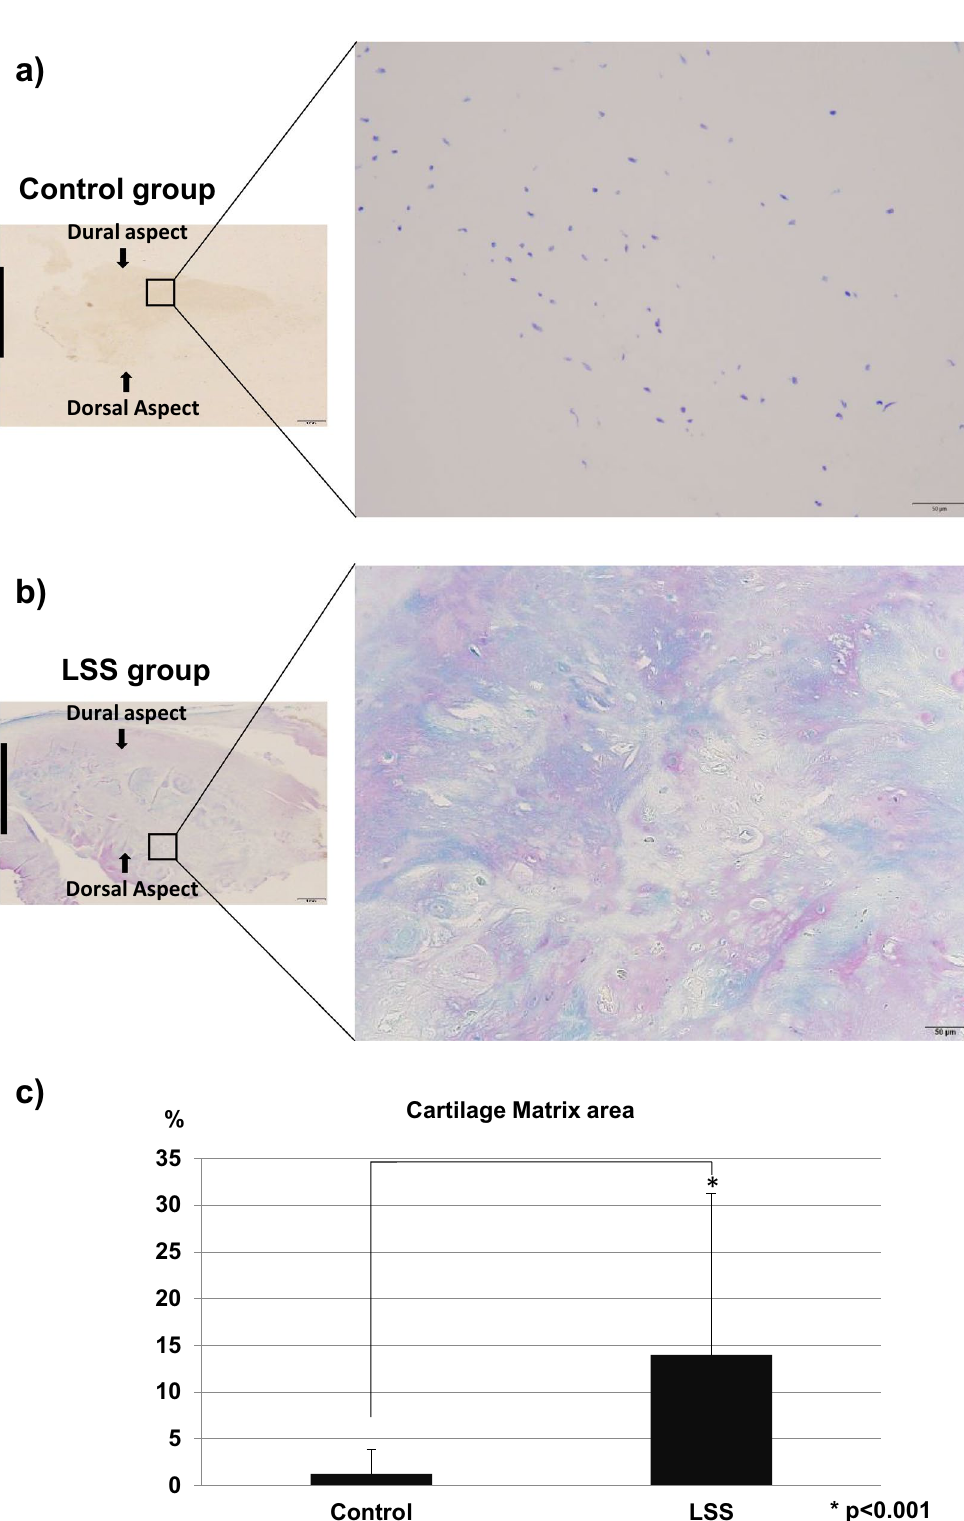
Figure 2. TB staining of ( a ) non-hypertrophied (control) LF and ( b ) hypertrophied LF. Left, low magnification (×1.25; scale bar represents 1 mm). The dorsal and dural sides (arrows) and the midline (black line) are indicated. Right, high magnification (×20) of boxed area in left image. Scale bar represents 50 µm. ( c ) The percentage of cartilage matrix area stained with